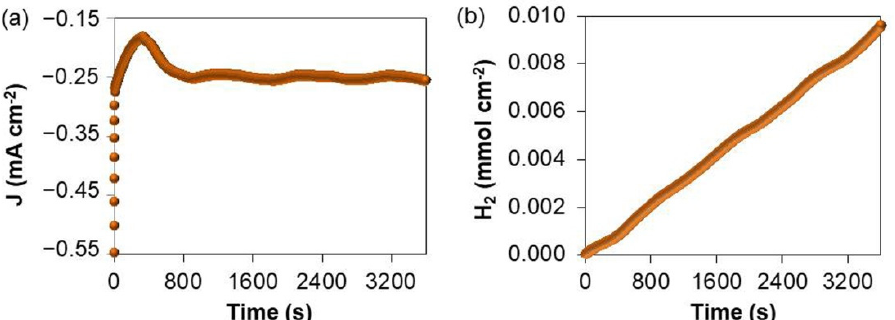
Figure 6. ( a ) The photo corrosion stability measurement and ( b ) the calculated H 2 production using S05150 CuO photocathodes. Table 2. The comparison of photoelectrochemical water splitting efficiency of CuO broccoli-like structure (S05150) and other materials.